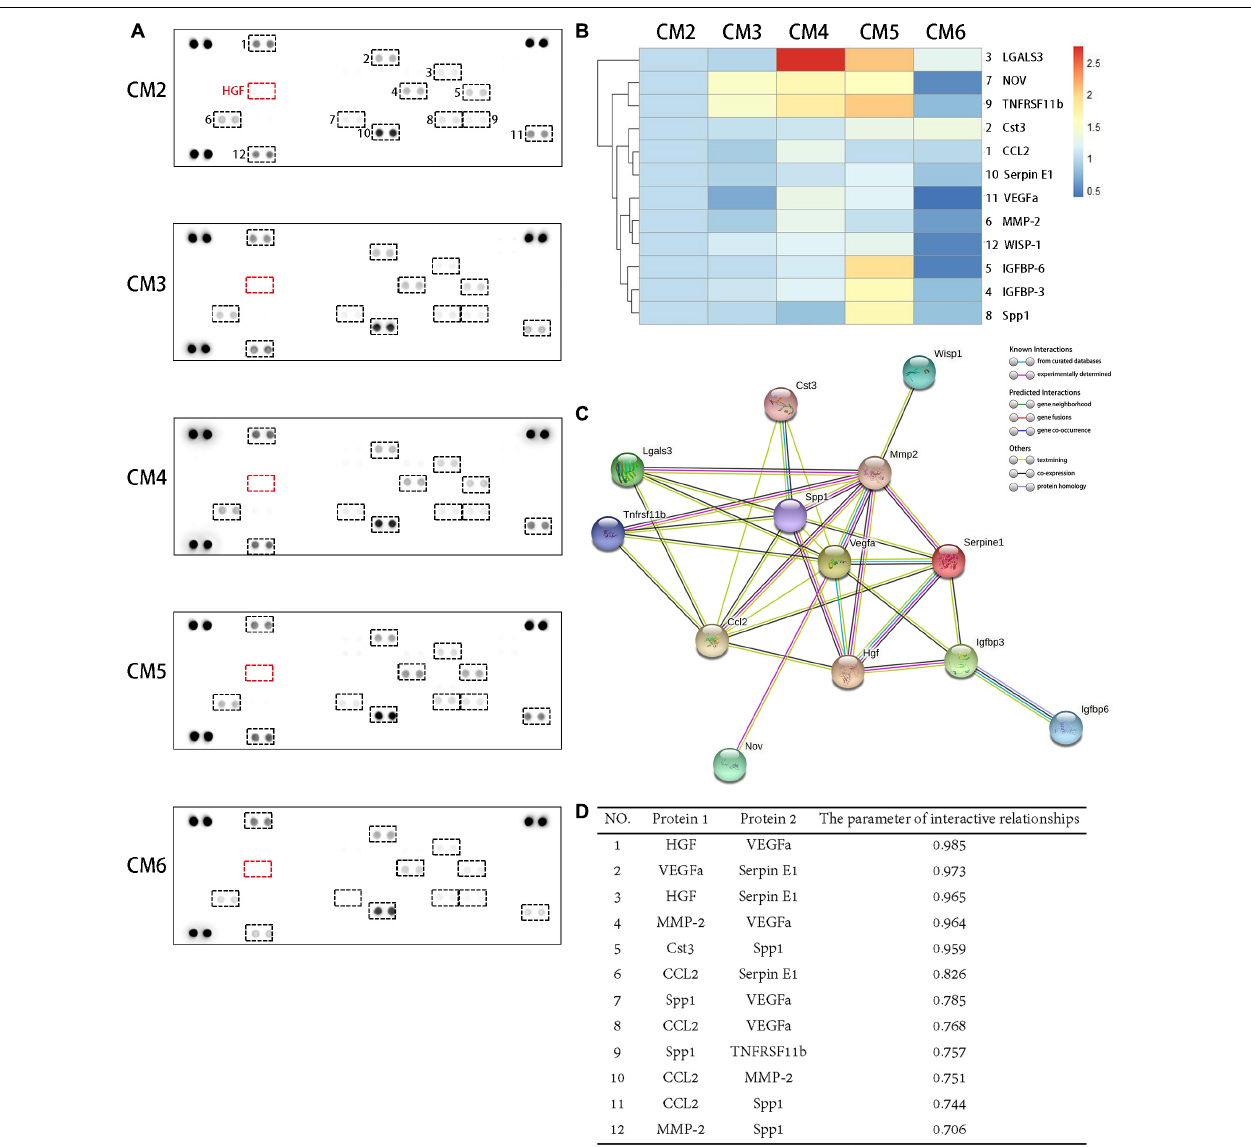
FIGURE 2 | Proteomic analysis of CM and PPIs of soluble bioactive molecules. (A) A total of 12 molecules were detected in the CM2 with the proteome profiler antibody array. The concentrations of soluble bioactive molecules can be modified by HGF. (B) A cluster analysis result was shown by a heat map. Compared with CST3, CCL2, Serpin E1, VEGFa, MMP-2, and WISP-1, the concentration variations of LGALS3, NOV, and TNFRSF11b were sensitive to the dose of HGF. While, only when the concentration of HGF was 40 mg/ml, the contents of IGFRP-6, IGFBP-3, and SPP1 changed obviously. (C) PPIs network of the 12 proteins detected in TSC CM and HGF. Known interactions are indicated by light blue (weak) or purple (strong) lines. (D) Protein pairs with interaction score > 0.7. HGF and VEGFa, VEGFa and Serpin E1, HGF and Serpin E1, MMP-2 and VEGFa, CST3 and SPP1 showed strong interactions ( > 0.9).